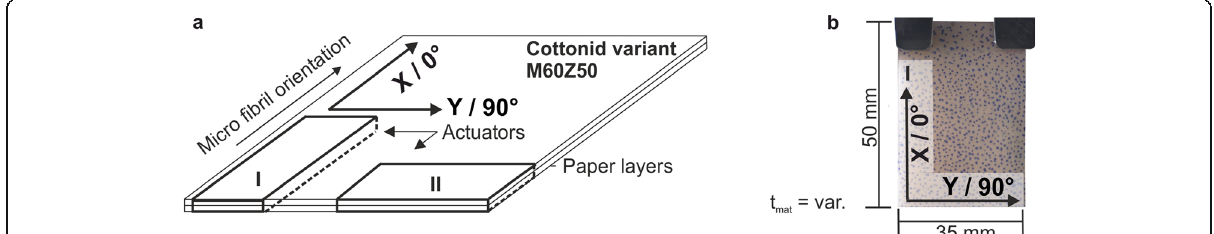
Fig. 1 Specimen preparation for actuation experiments: a Specimen location in Cottonid sheet according to manufacturing direction of paper layers, and b Cottonid actuator type I with speckled surface for strain measurements via digital image correlation (DIC) mounted in customized specimen